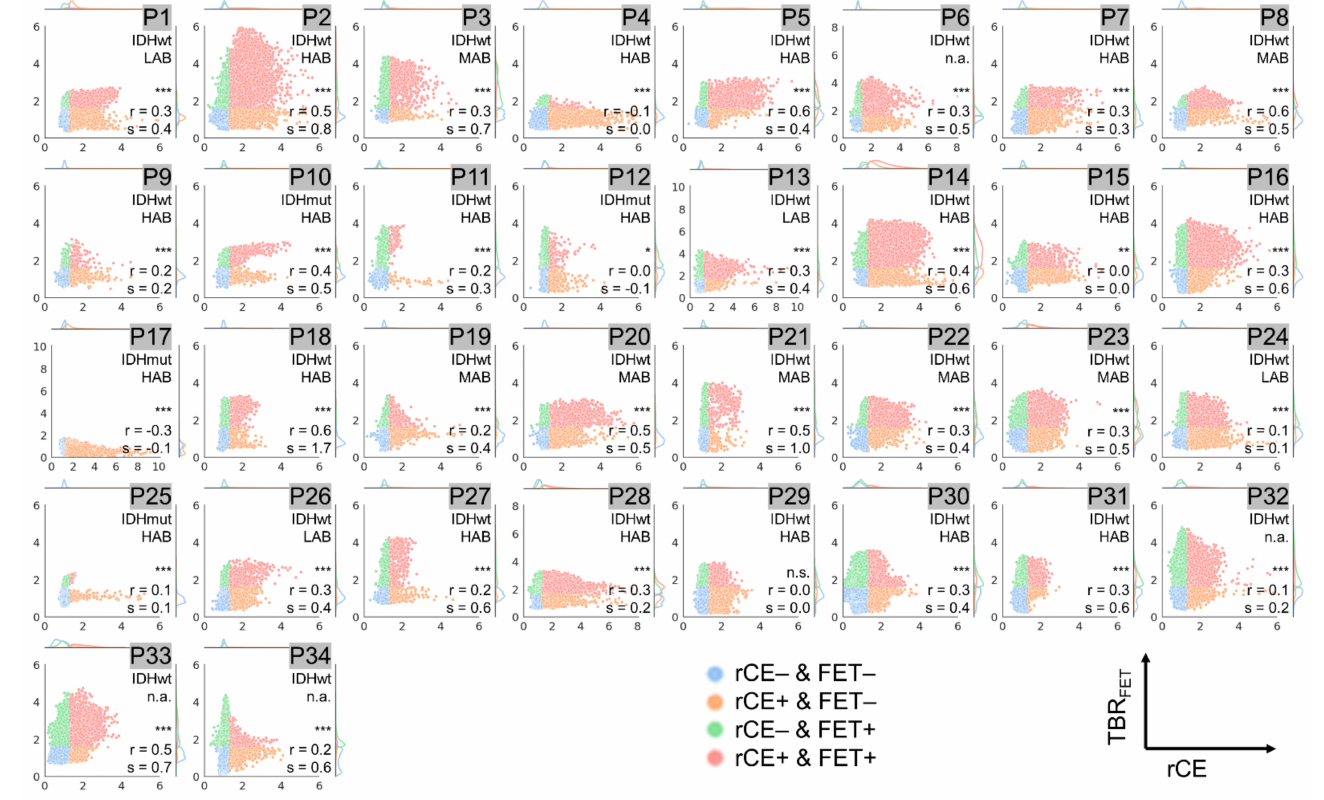
Figure 4. Voxel-wise correlation of [ 18 F]FET tumor-to-background ratios (TBR FET ) vs. relative contrast enhancement (rCE) values for patients P1–P34. The depicted data points are color coded as described in Figure 2: Red: rCE and TBR FET positive voxels, Blue: rCE and TBR FET negative voxels, Orange: rCE positive and TBR FET negative voxels, Green: rCE negative and TBR FET positive voxels. Significances obtained from Pearson’s correlation and the corresponding correlation coefficients (r) and slopes (s) are provided in the lower right corner. Significance was grouped as strong ( p < 0.001, denoted with ***), medium ( p < 0.01, **), low ( p < 0.05, *), and not significant (n.s.). The status of IDH mutation (IDHmut: with IDH1/2 mutation; IDHwt: without mutation) and the TSPO-polymorphism genotype are given for each patient in the upper right corner (if not available denoted with n.a.). The axis ranges are all fixed to values between zero and six except for patients P6, P13, P17, and P28 where the upper limit was adapted due to higher voxel